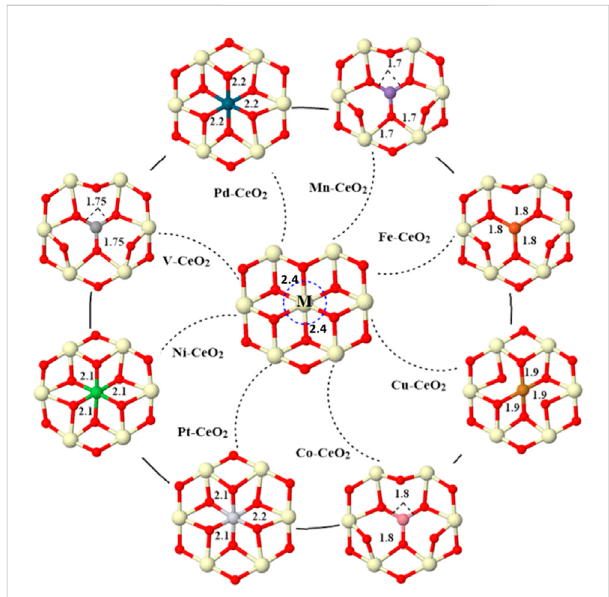
FIGURE 1 Optimized geometries of all doped surfaces. One of the surface cerium atoms is replaced with a dopant metal (Pd, Mn, Fe, Cu, Co, Pt, Ni, and V). The bond distance between the dopant and the fi rst neighbor oxygen is indicated in Å. Cerium is light yellow, and oxygen is